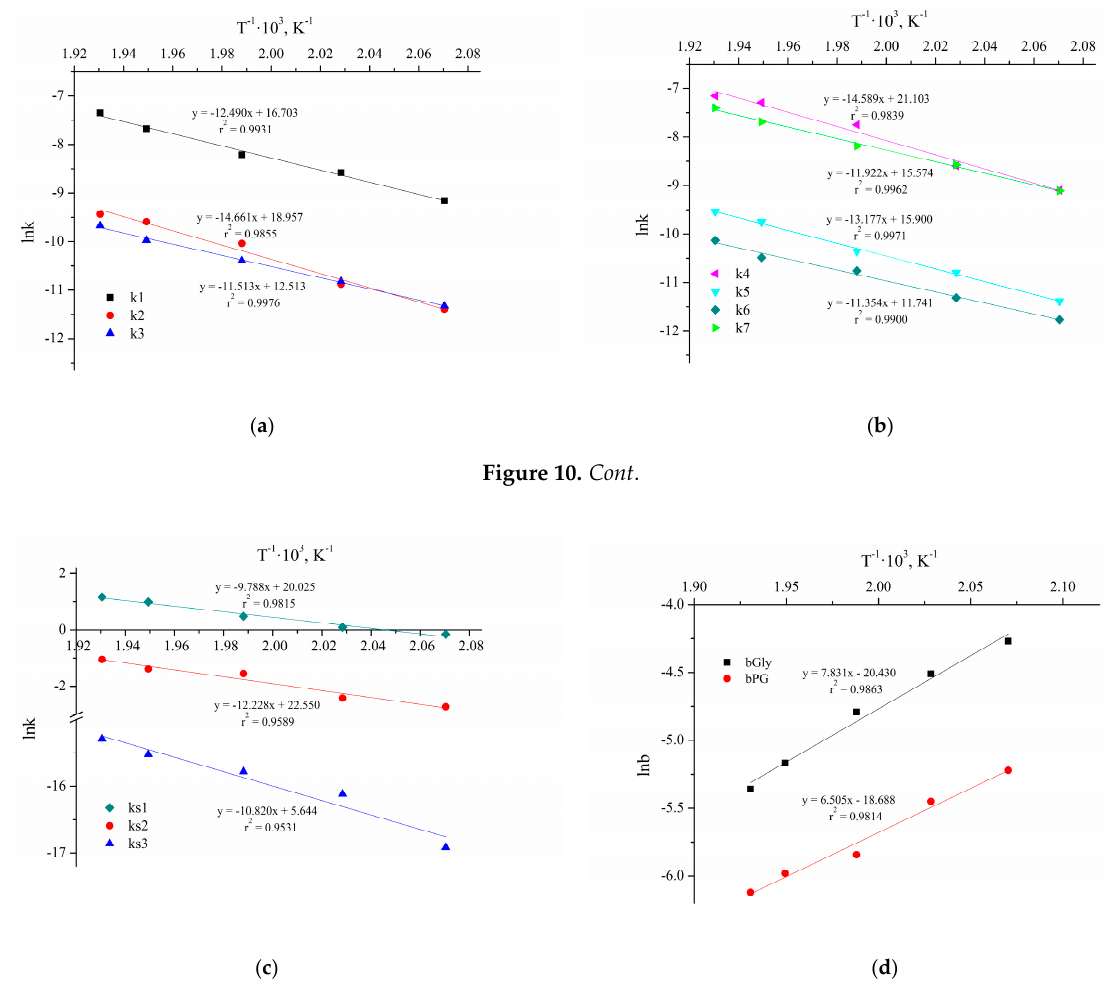
Figure 10. The Arrhenius plots for the reactions without Cu NPs ( a , b ) and with Cu NPs and NaOH ( c , d ).